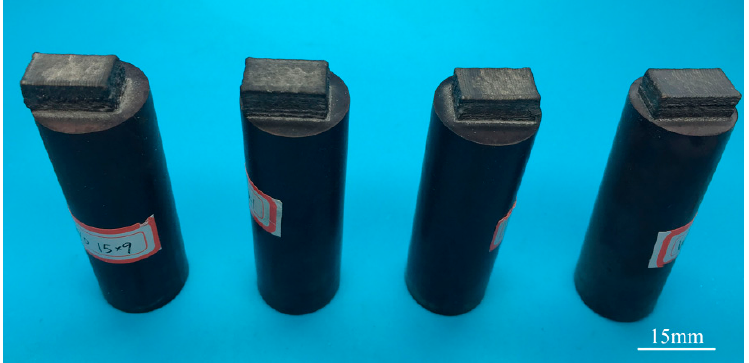
Figure 3. Macroscopic photograph of the W x NbMoTa alloys.